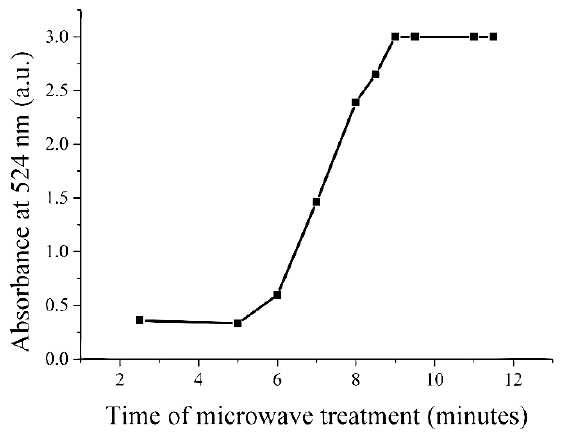
Figure 2. Intensity of samples absorbance at 524 nm.